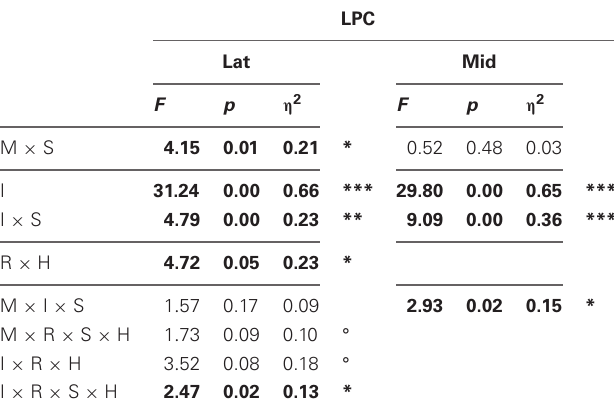
Table 2 | Results of the omnibus lateral (Lat) and midline (Mid) ANOVAs for the P3b (probe vs. irrelevants, 400–600ms).